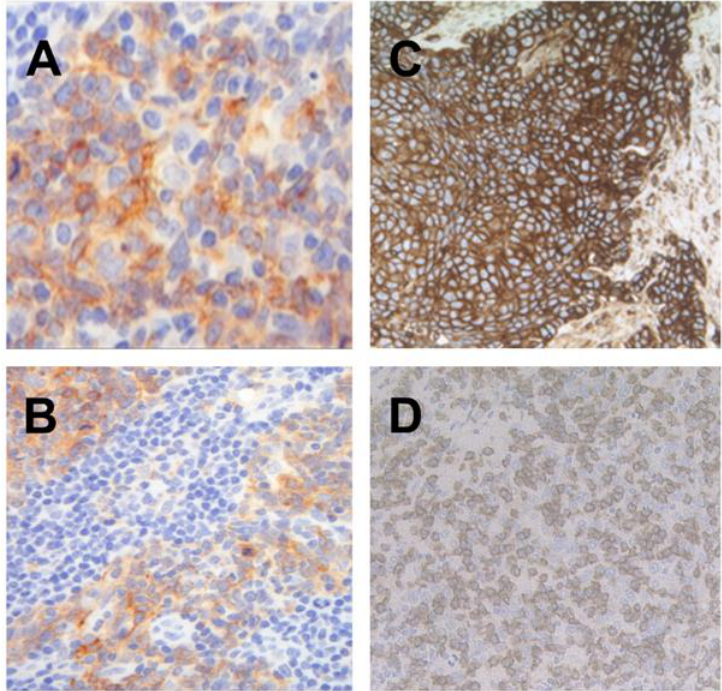
Figure 1. Expression of programmed cell death protein 1 ligand 1 (PD-L1) on tumor cells (TC; ( A ), magnification 200×) and intra- and peritumoral macrophages ( B ), magnification 100×). Strong homogenous staining for major histocompatibility complex class I (MHC I) ( C ), magnification 100×) and membrane-pattern CD8 positive lymphocytes in oropharyngeal squamous cell carcinoma (OPSCC; ( D ), magnification 100×).